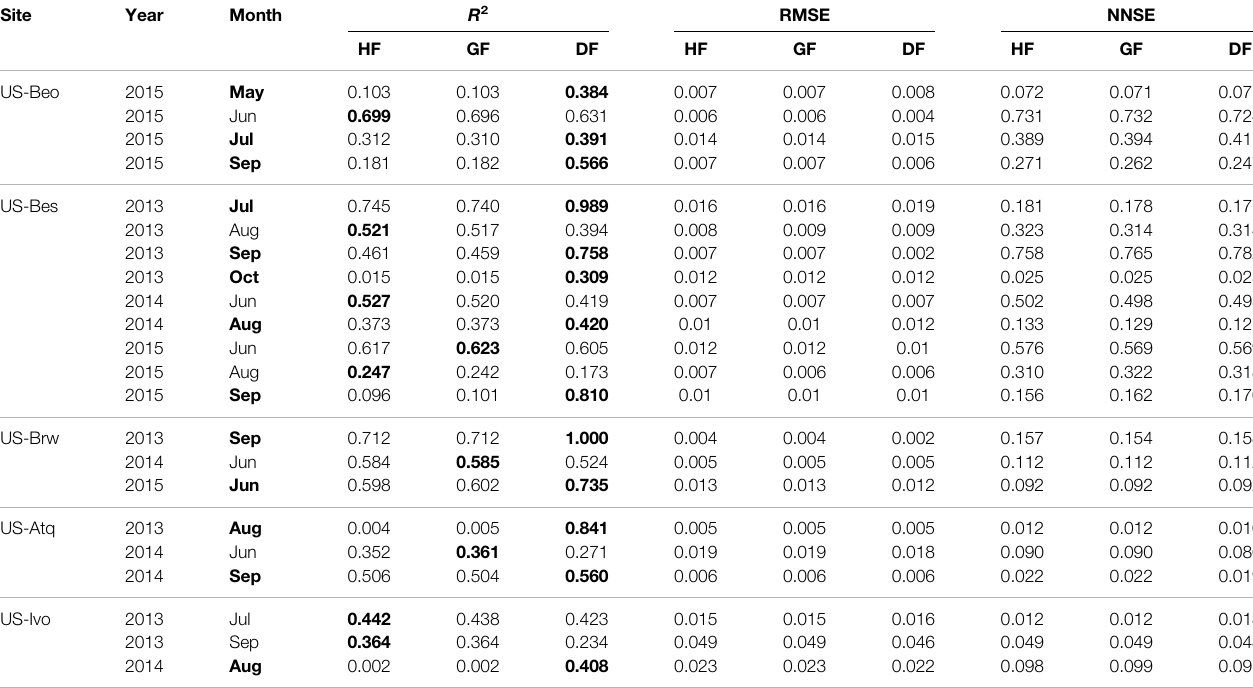
TABLE 2 | Coef fi cients for simulated daily CH 4 fl ux for each month using the homogeneous footprint (HF), gradient footprint (GF) and dynamic footprint (DF) algorithms comparedwithobserved fl uxforallstudysites.(RMSE:rootmeansquareerror;Boldedvaluesaresigni fi cantat p =0.5;NNSE:theNormalizedNash-SutcliffeEf fi ciency).